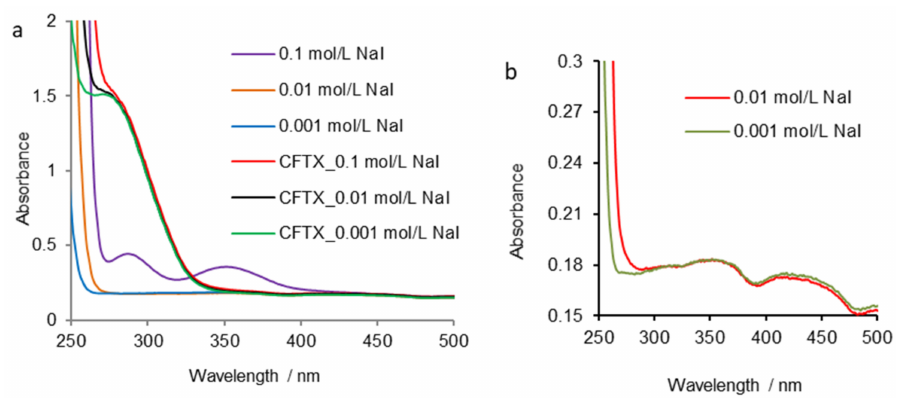
Figure 4. UV-Vis spectra of NaI solution of various concentrations in the absence and presence of CFTX ( a ) and detailed UV-Vis spectra for 0.01 mol L − 1 and 0.001 mol L − 1 respectively, NaI solution ( b ).